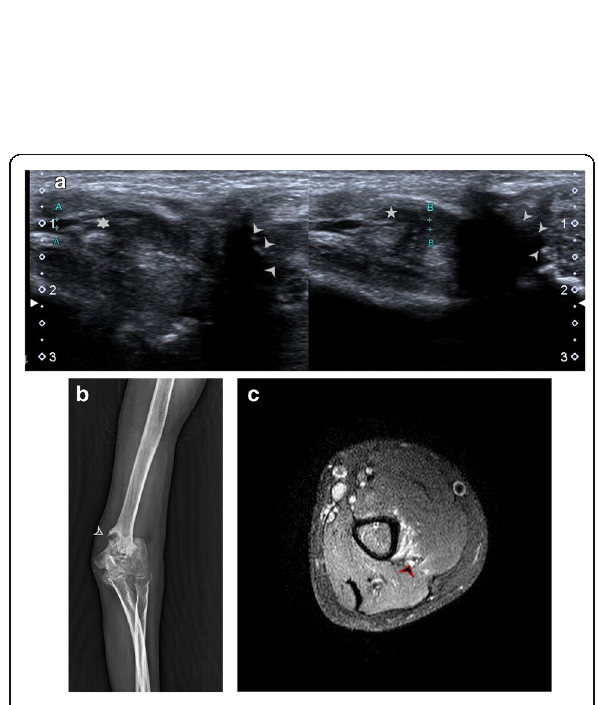
Fig. 7 a There is a cystic lesion (between callipers) causing direct compression over the ulnar nerve (yellow arrow) which appears hypoechoic. b PD FS axial and sagittal image demonstrate a hyperintense ulnar nerve (yellow arrow) which is getting compressed by a hyperintense cystic lesion (red arrow). c Per operative picture showing the ulnar nerve (yellow arrow) and the cyst (blue arrow). Histopathology revealed it to be a ganglion cyst. d Anechoic cystic lesion (red arrow heads) adjacent to the ulnar nerve (yellow arrow) at the elbow is seen with underlying cortical erosions (red arrow). The cystic lesion appears to arise from the nerve, suggestive of an intraneural ganglion cyst. e The hyperintense cystic lesion (red arrow heads), as seen in 5D, is seen arising from the adjacent hyperintense ulnar nerve (yellow arrow) lying along the course of the nerve on T2-weighted image [23]. Also noted are osteophytes (red arrow). f High-resolution ultrasound image showing common peroneal nerve (arrowheads) lying stretched over the underlying cystic lesion. g Hyperintense CPN is noted in this axial PDFS image (between crossheads) just before it wraps around the neck of fibula. The nerve is hyperintense as it is passing over the underlying cysts as seen on the right. PDFS image on the right shows hyperintense cysts which on excision biopsy proved to be ganglion cysts. h T1-weighted fat saturated post-contrast image shows enhancing cyst walls with no internal enhancement (arrow) suggestive of cystic nature of the lesion. Also seen is enhancement of the sheath of the common peroneal nerve (arrowhead) lying in close proximity to the cyst